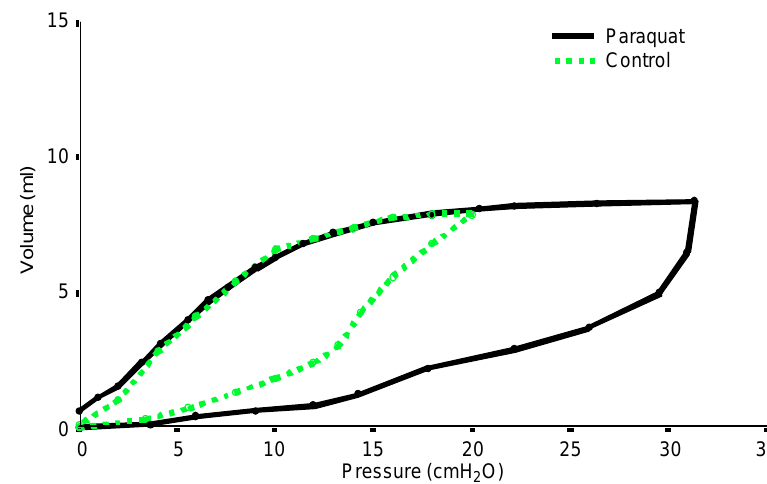
Figure 2 - Static pressure-volume curves obtained in air-filled lungs from a control rat and a paraquat (25 mg/kg body weight)-intoxicated rat. The inspiratory limb was shifted to the right in the paraquat-treated animal. In addition, hysteresis was markedly increased after paraquat